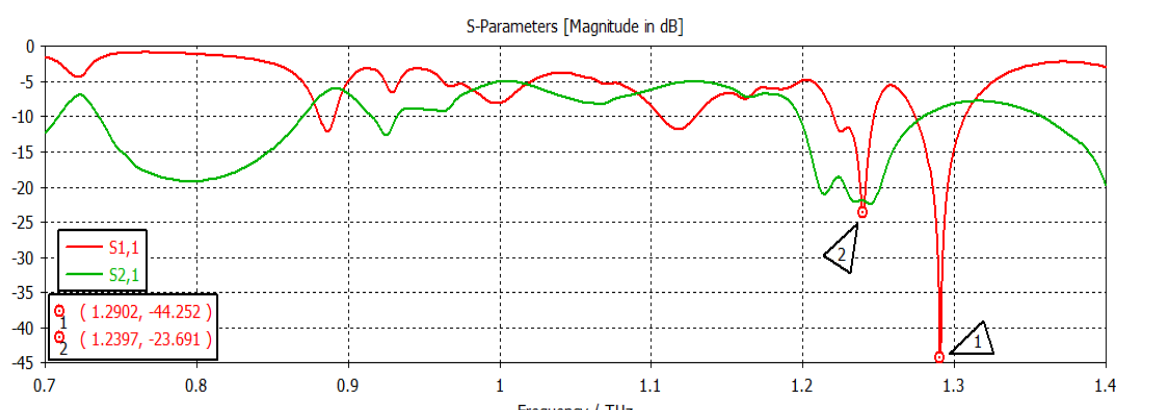
Figure 4. Current distribution.